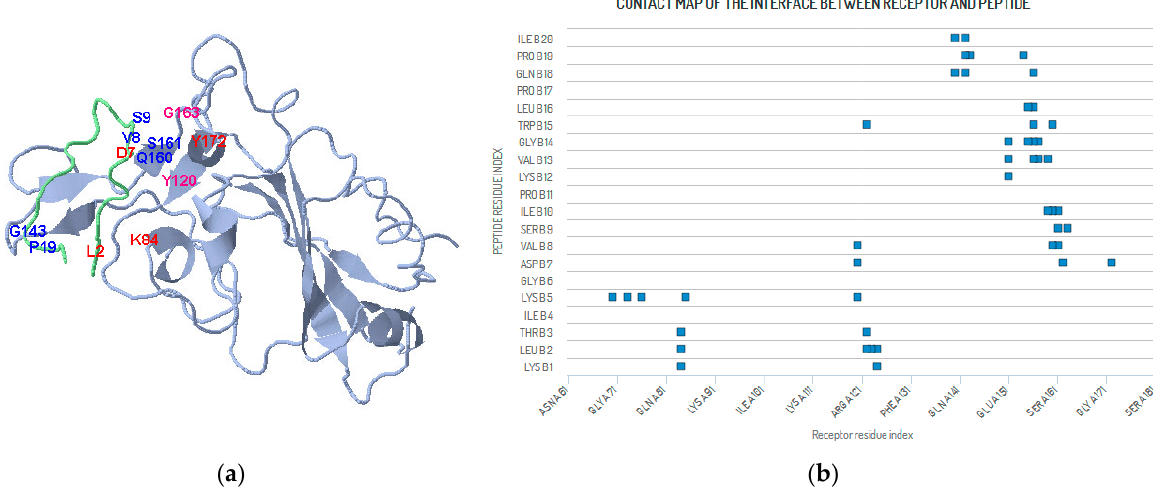
Figure 4. ( a ) Docking of antisense peptide KLTIKGDVSIPKVGWLPQPIV to RBD of S1 SARS-CoV-2 by means of a CABS- dock server (Table S2: model 1) [28]. Pairs of peptide/receptor residuals: in 3 ′ → 5 ′ direction marked blue, in 5 ′ → 3 ′ direc- tion marked red, otherwise magenta; ( b ) Contact map of the interface between antisense peptide and its receptor residues in a complex closer than 4.5 Å (Tables A3 and S2: model 1).